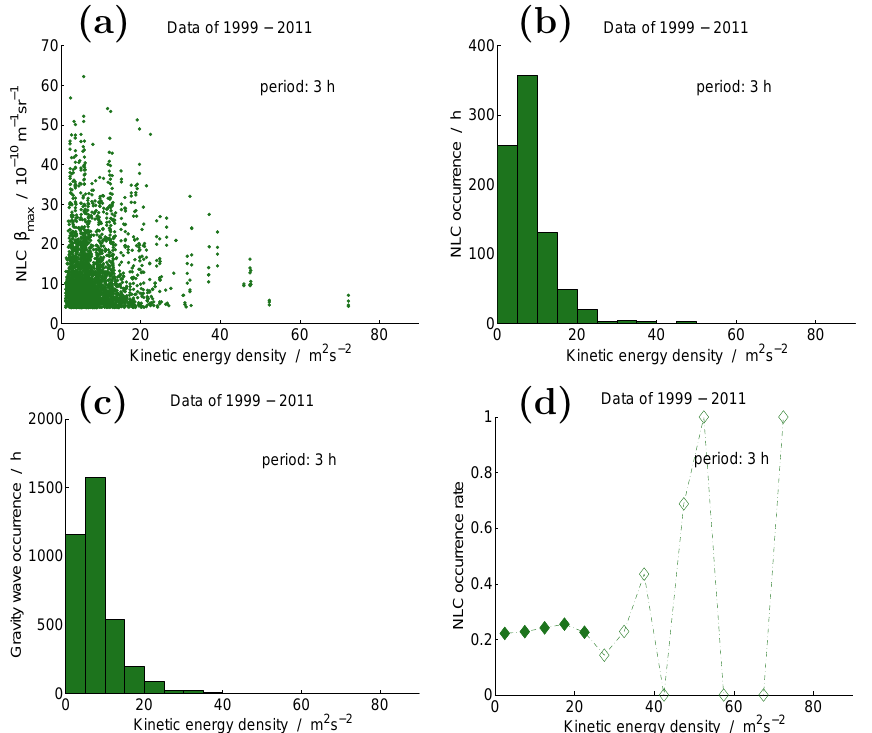
Fig. 2. (a) NLC backscatter coefficient β max vs. gravity wave kinetic energy density in the 2h to 4h period band. (b) Total time of NLC detection during simultaneously identified gravity wave activity of the 3h wave in different energy bins (histogram of a ). (c) Total time of gravity wave occurrence of the 3h wave in different energy bins during the complete lidar measurement time independent of NLC detection. (d) NLC occurrence rate (ratio of NLC detection time to total measurement time) in different energy bins. Open symbols indicate occurrence rates based on less than 5h of NLC